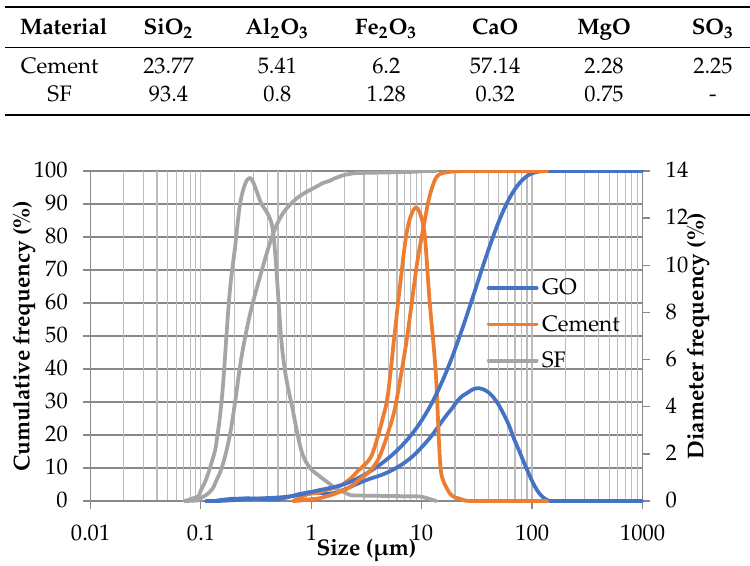
Figure 1. Particle size distribution of cement, SF, and GO sheets.